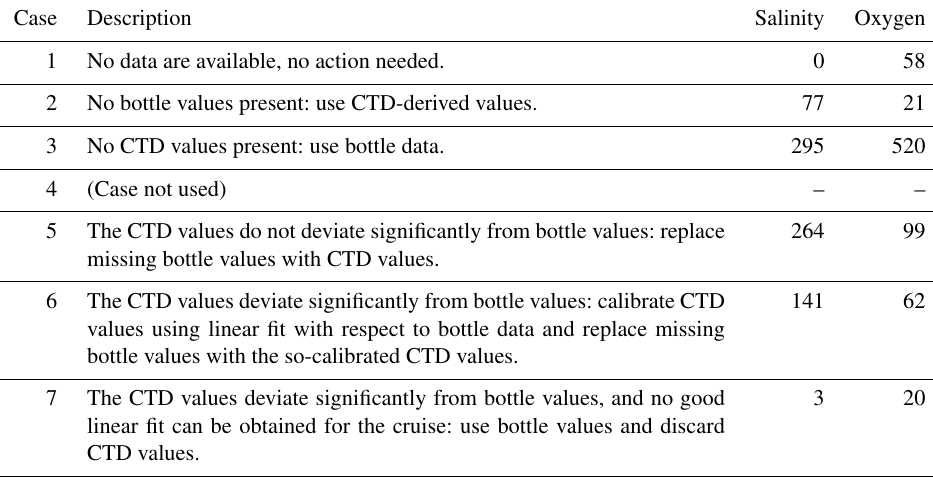
Table 8. Summary of salinity and oxygen merger actions for the 780 non-dismissed entries subjected to secondary QC. Case